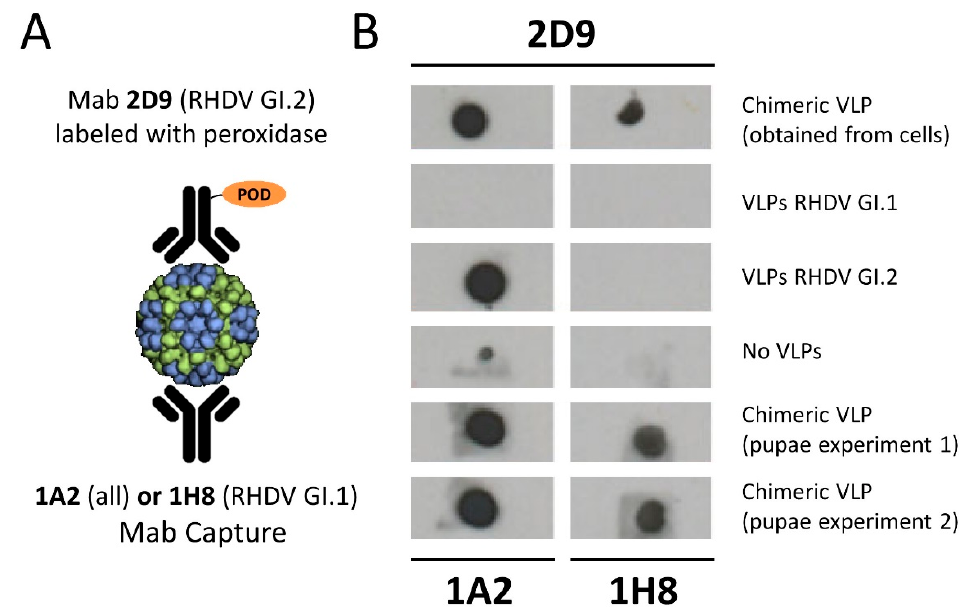
Figure 3. Determination of the incorporation RHDV GI.1- and RHDV Gi.2-derived VP60 proteins into the chimeric VLP by dot blot using different Mabs. ( A ) Design of a capture dot blot using a Mab (1A2) with broad recognition of RHDV serotypes or a RHDV GI.1-specific Mab (1H8) to capture the purified chimeric VLPs. Immune complexes were revealed with an RHDV GI.2-specific Mab (2D9). ( B ) Dot blot results obtained in the different assays. All dot blots were positive for the chimeric VLPs when both capture antibodies were used, indicating the dual VP60 composition of the VLP. Negative results were obtained with the VLP obtained from infections with a single recombinant baculovirus expressing the VP60 from RHDV GI.1 and RHDV GI.2 (captured with Mab 1H8) and control samples. The full uncropped dotblot is included as supplemental Figure S2.